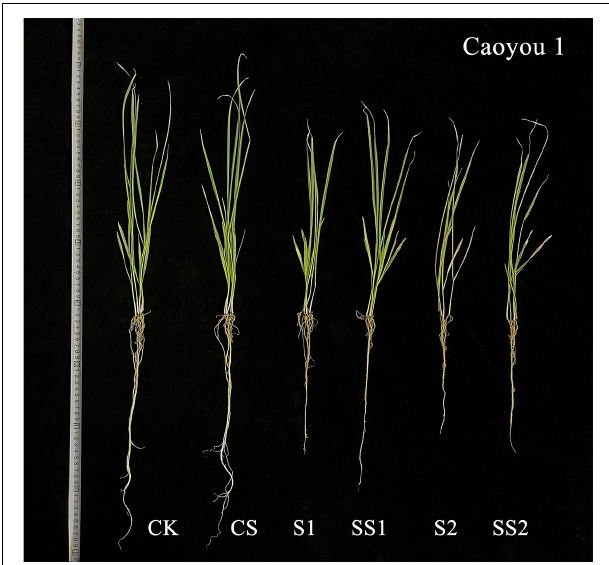
FIGURE 11 | Effects of Spd application on the growth under Salt Stress in salt-tolerant cultivar Baiyan 2. CK, Nutrient solution + distilled water; CS, Nutrient solution + 0.75 mM Spd; S1, 70 mM salt + distilled water; SS1, 70 mM salt + 0.75 mmol/L Spd; S2, 100 mM salt + distilled water; SS2, 100 mM salt + 0.75 mmol/L